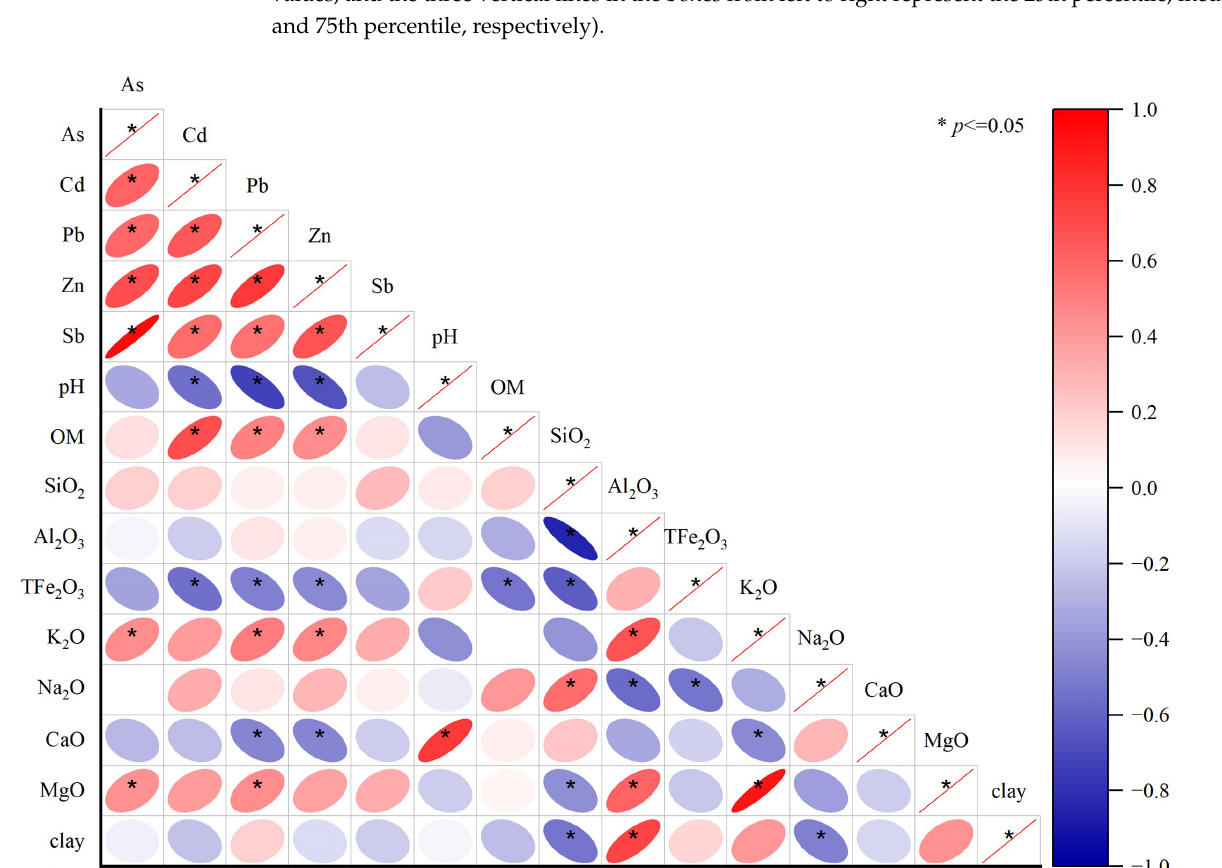
Figure 6. Correlation between bioavailable metals and physicochemical properties in the topsoil of the study